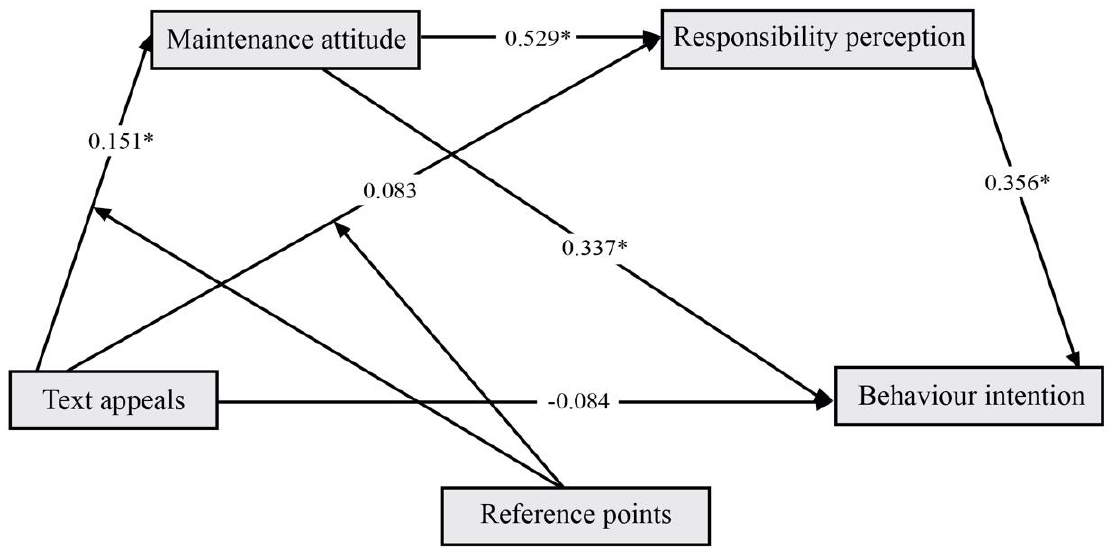
Figure 5. The research framework and path coefficients (the standardized regression coefficient). * p ≤ 0.05.